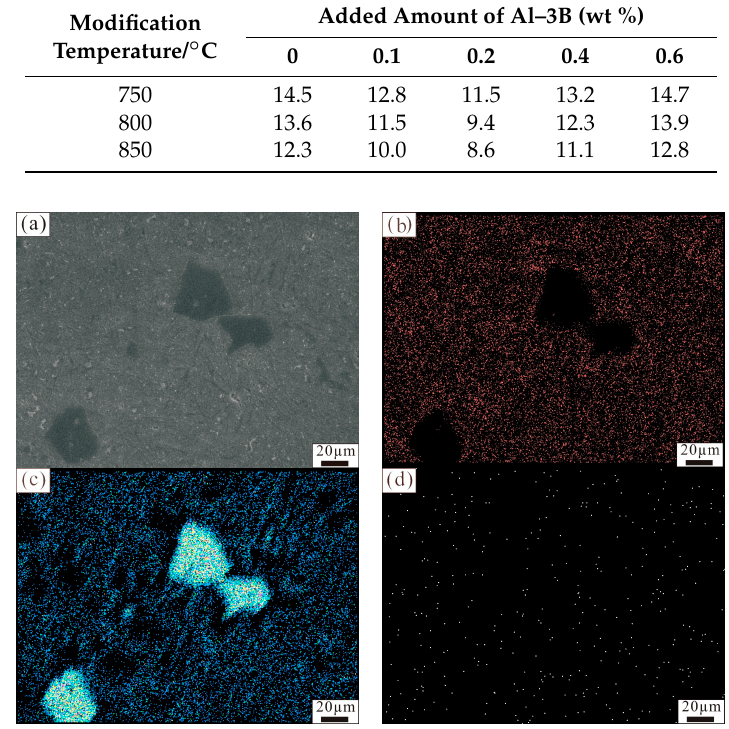
Figure 2. The area maps of the elements distribution in the modified Al–18Si alloy. ( a ) Microstructure of the Al–18Si alloy; ( b ) Map of Al distribution; ( c ) Map of Si distribution; ( d ) Map of B distribution.